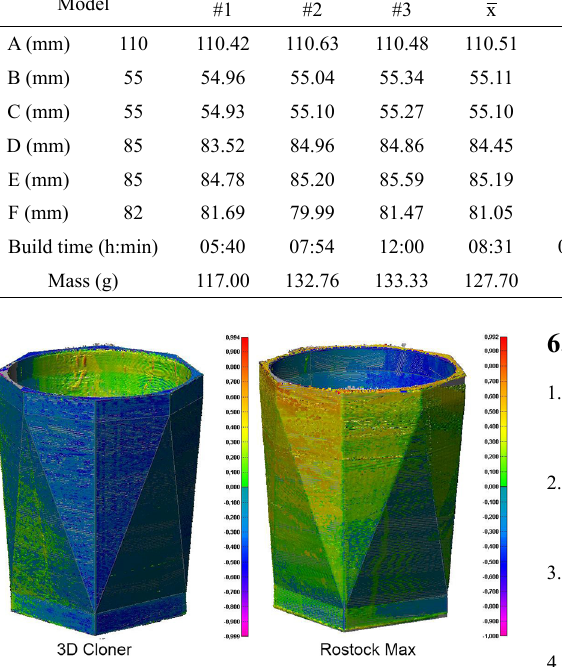
Table 1. Results of build time, dimensional and mass measurements of printed objects. CAD Model